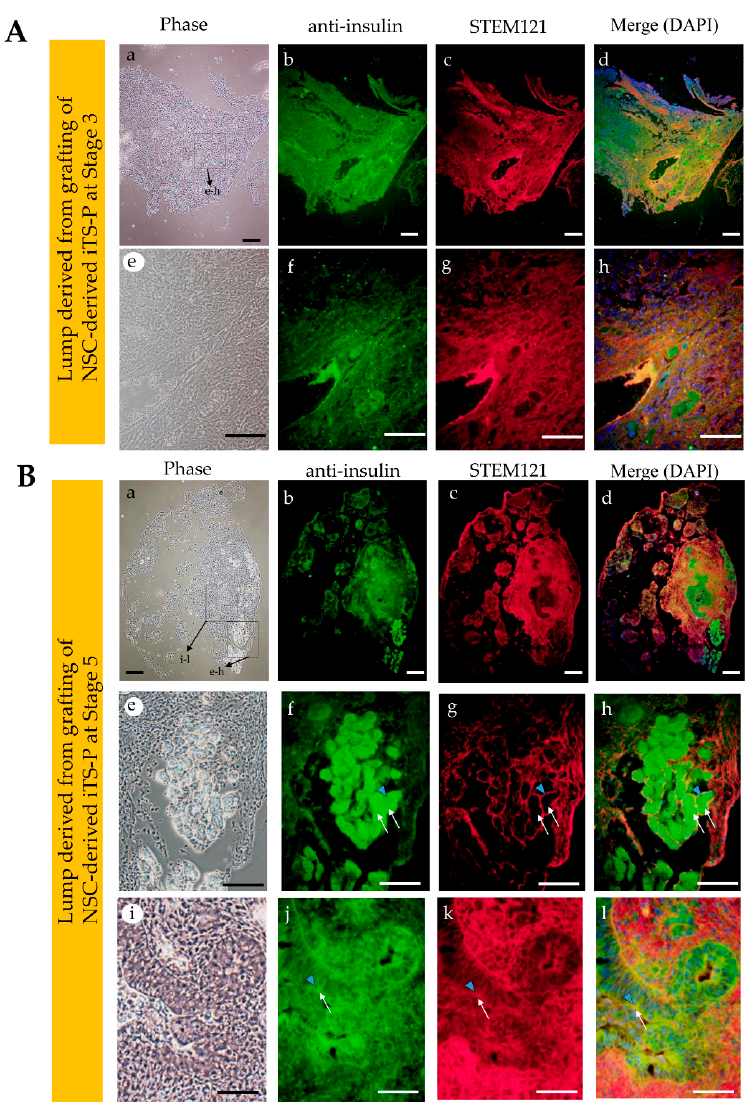
Figure 5. Immunohistochemical staining of cryostat sections stained with anti-insulin (Green) and STEM121 (Red). ( A ): The lump (derived from grafting of induced tissue-specific stem cells for pancreatic cells [iTS-P] at Stage 3) grown in the pancreas of nude mouse (which was located near the side shown in Figure 4B(f,g)), after staining with anti-insulin antibody, and subsequently with human cells-specific monoclonal antibody STEM121. Magnified images in (e–h) are derived from a box shown in (a). Bar = 100 µ m. ( B ): The lump (derived from grafting of iTS-P at Stage 5) grown in the pancreas of nude mouse (which was located near the side shown in Figure 4B(h–j)) after staining with anti-insulin antibody, and subsequently with STEM121. Magnified images in (e–h) and (i–l) are derived from boxes shown in (a). The portion shown in a-l was highly reactive to anti-insulin antibody (b). When the glandular cells, which showed extensive staining by anti-insulin antibody (arrowhead in (f,j)), were assessed carefully, it was observed that the intracellular portion of these cells was also stained with STEM121 (arrows in (g,k)), suggesting that these insulin-positive cells are indeed derived from human grafts. In contrast, in the islet-like structure, which was located near the glandular cells, the outer surface of the islets was stained with STEM121 (arrowhead in (g)), but the intracellular portion of these cells was not stained with this antibody (arrows in (g)), suggesting that these islet-structures were of mouse (host) origin. Bar = 100 µ